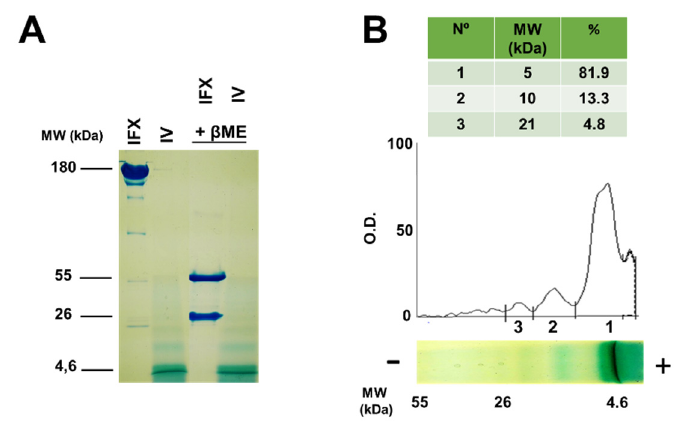
Figure 8. ( A ) Electrophoresis of infliximab (IFX) and compound IV using SDS-PAGE. ( B ) Densitometric analysisofelectrophoresisofcompoundIVinabsenceof β ME( β -mercaptoethanol). O.D. =